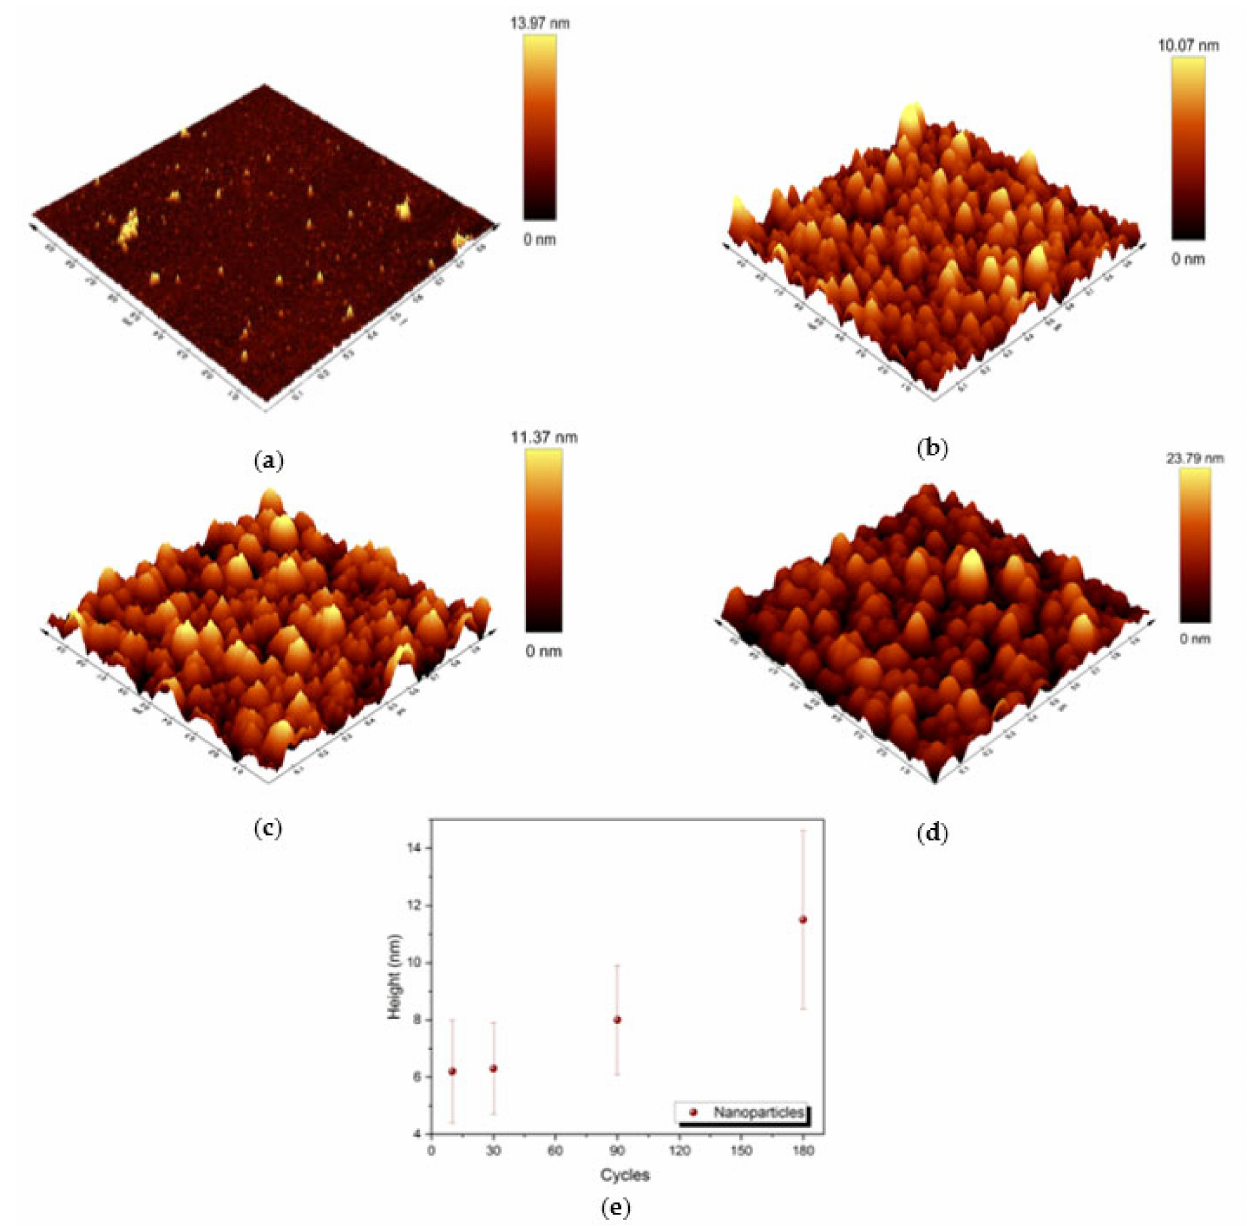
Figure 5. Three-dimensional view of 1 µ m × 1 µ m AFM images of samples: ( a ) D; ( b ) E; ( c ) F; ( d ) G; ( e ) correlation between the medium height of the nanoparticles and the number of deposition cycles in samples